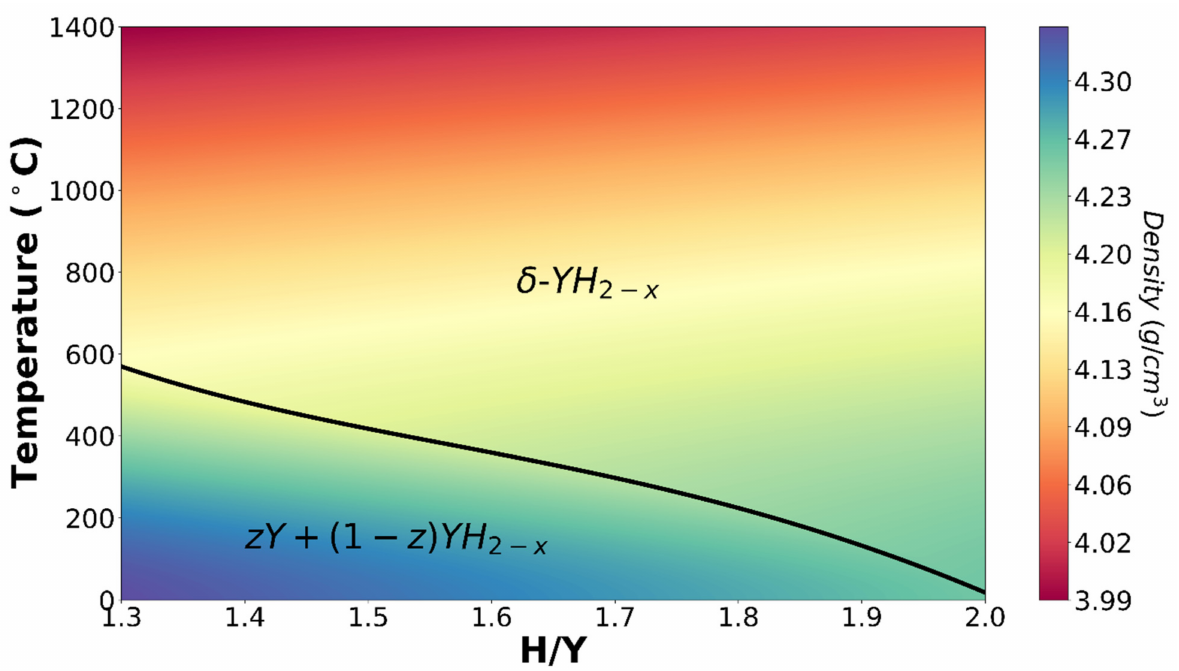
Figure 8. DFT-derived density as a function of stoichiometry and temperature. Phase boundary taken from Peng et al.